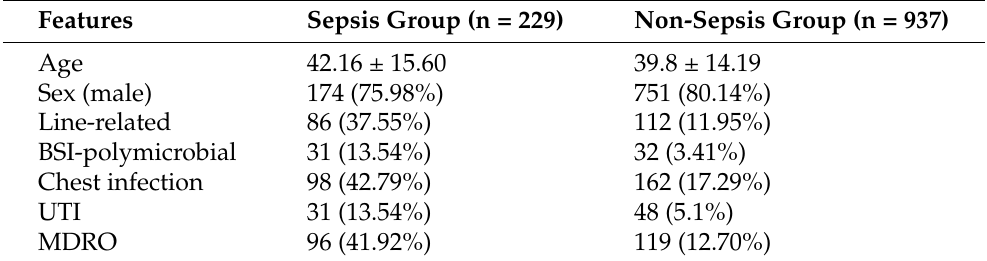
Table 2. Distribution of features in the sepsis and non-sepsis groups, number of FNEs, n = 1166. Along with the features listed below, other multi-category features, such as region of origin, diagnostic category, treatment phase, disease status, and type of microorganism in the bloodstream, were used to predict sepsis. A total of 12 variables were used in the model to predict sepsis.